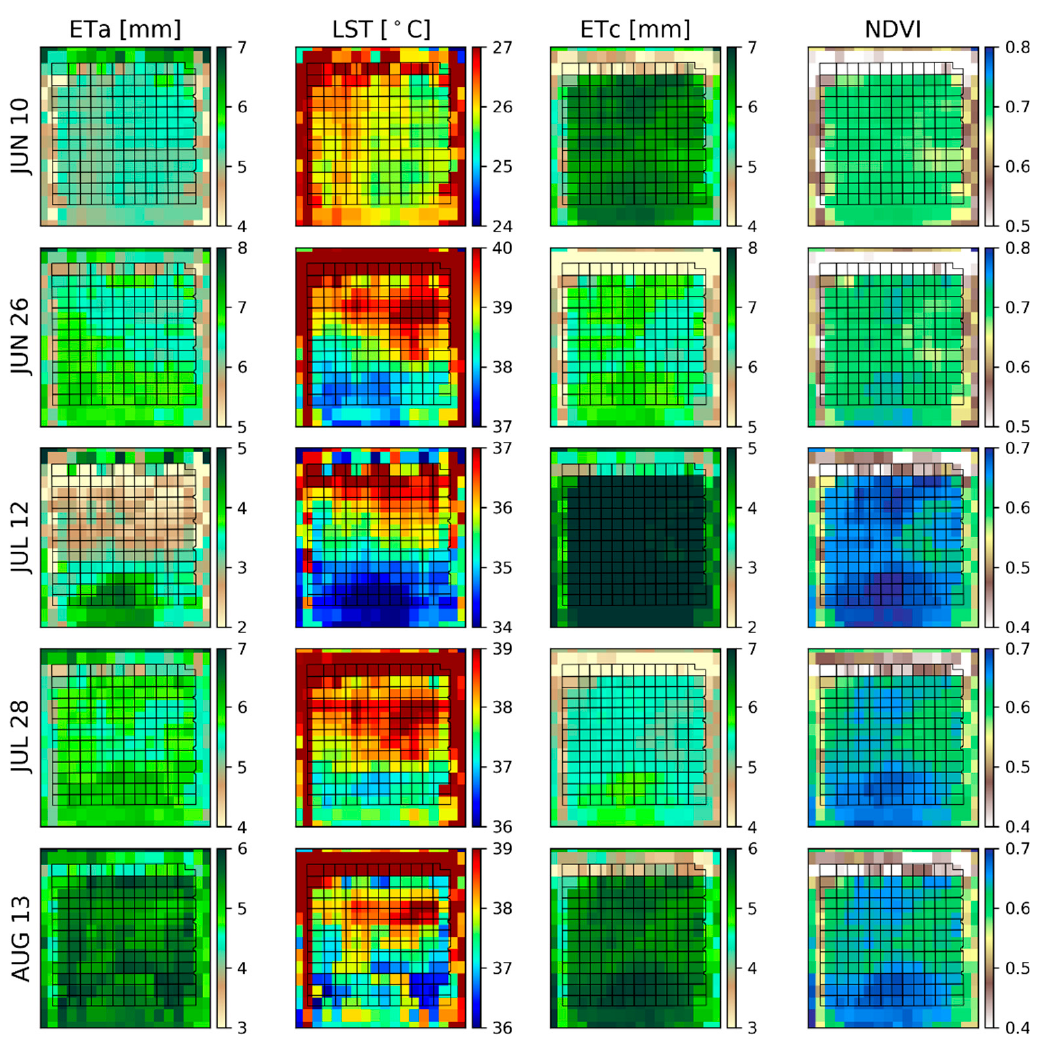
Figure 5. Spatial maps of ET a -retro (left column), LST (second from left column), ET c (third from left column), and NDVI (right column) over the VRDI (black grid) equipped vineyard for Landsat 8 T1 overpass dates specified on the y-axis. Note that scales are representative of the vineyard range for each model run to best portray spatial discrepancies between models and dates; however, the magnitude of the color bar range is fixed. Table 2. Average difference in daily ET (mm day − 1 ) between southern and northern portions of the vineyard for Observed, ET a -OP and ET c .